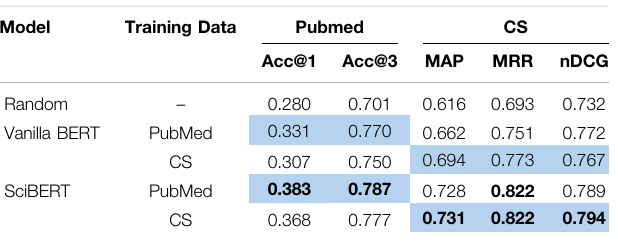
TABLE 4 | Performances of our vanilla BERT and SciBERT models trained on the PubMed and CS data set evaluated on the PubMed and CS data set compared against the random baseline. For PubMed, we report Accuracy@1 (Acc@1) and Accuracy@3 (Acc@3), for CS we report Mean Average Precision (MAP), Mean Reciprocal Rank (MRR) and Normalized Discounted Cumulative Gain (nDCG). We indicate the best model performances in bold, and the in- domain setup in light